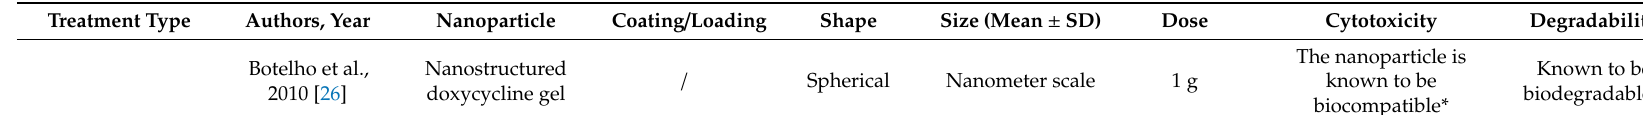
Table 2. The reported nanoparticles: characteristics, dose and